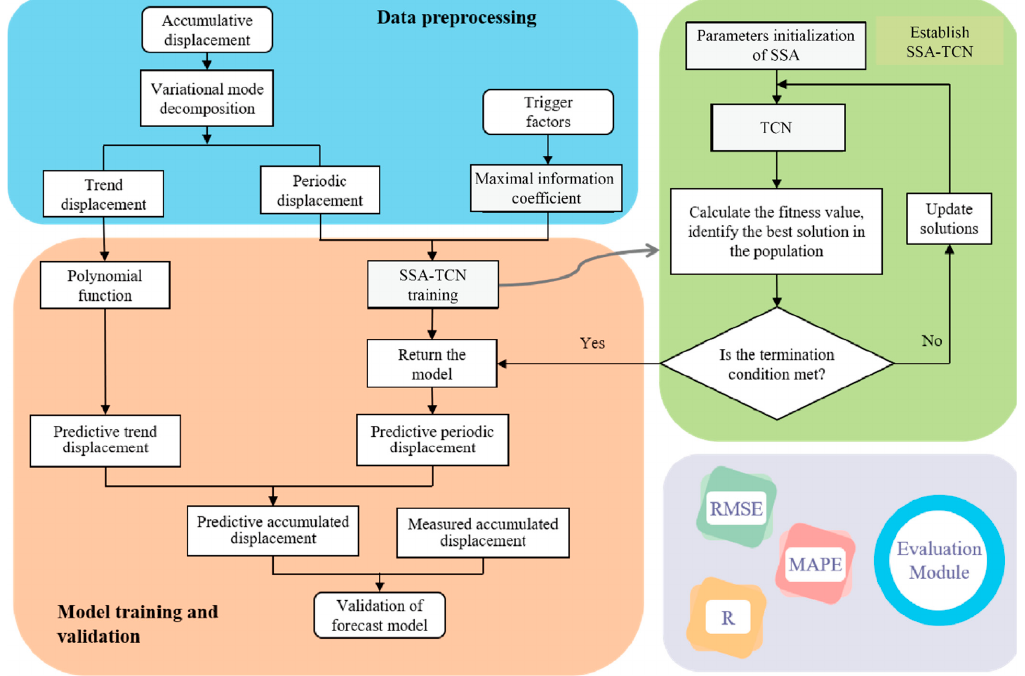
Figure 3. The flowchart of the proposed forecast model.